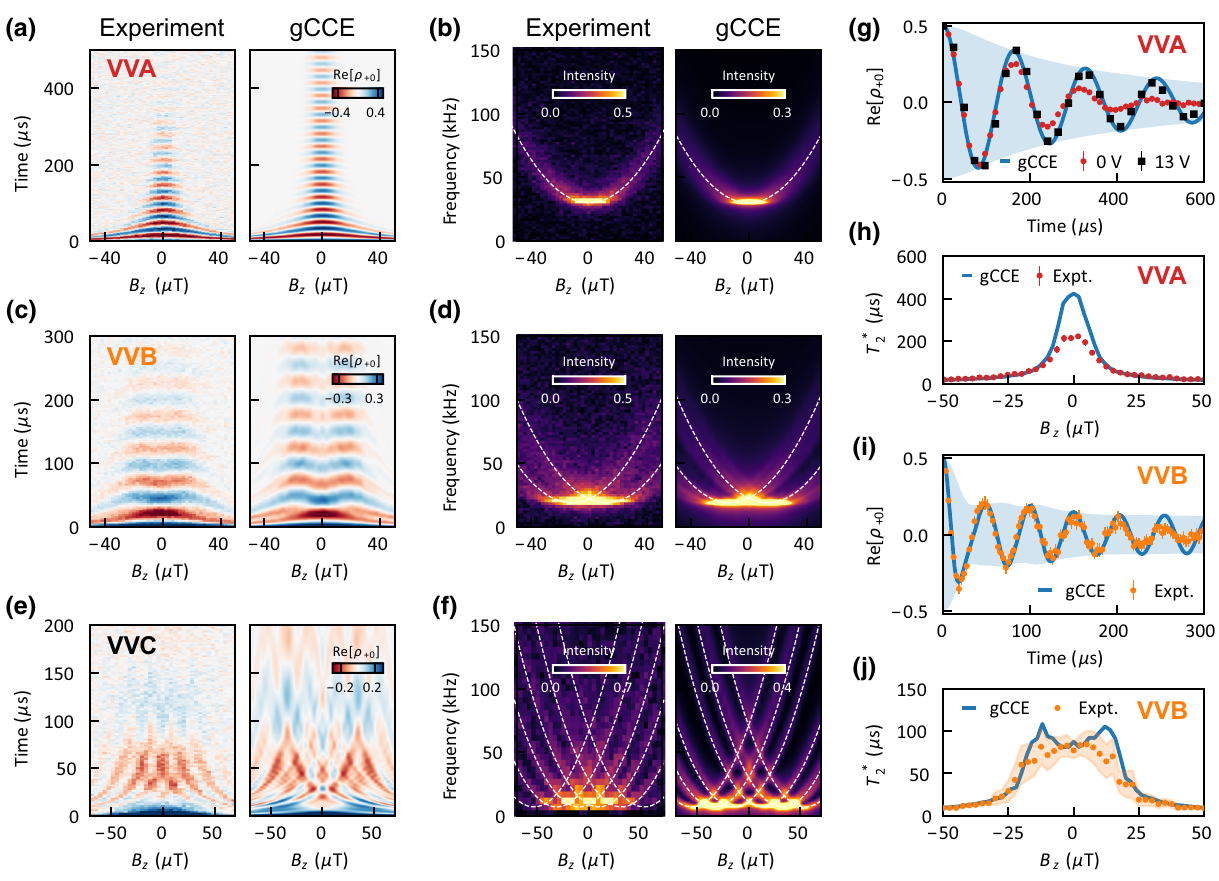
FIG. 3. Ramsey interferometry for three experimental kh -V C V Si systems. (a)–(f) Ramsey precession and frequency spectrum for a defect (a),(b) with only weakly coupled nuclear spins (VVA), (c),(d) with one strongly coupled nuclear spin (VVB), and (e),(f) with three strongly coupled nuclear spins (VVC). For each defect, we show theoretical predictions and experimental results. White dashed lines show the positions of the hyperbolae [see Eq. (4)]. (g) Measured Ramsey precession of VVA at zero field with (black) or without (red) charge depletion (see the text), compared to the theoretical prediction (blue). The shaded area corresponds to the theoretically for VVA (h) and VVB (j) as a function of the magnetic field ( B z ). Shaded area in (j) shows predicted decay. (h),(j) Distribution of T ∗ 2 the error of the fit. (i) Measured Ramsey precession of VVB at weak applied magnetic field ( B z = 12.5 μ T) compared to the theoretical prediction. Error bars correspond to